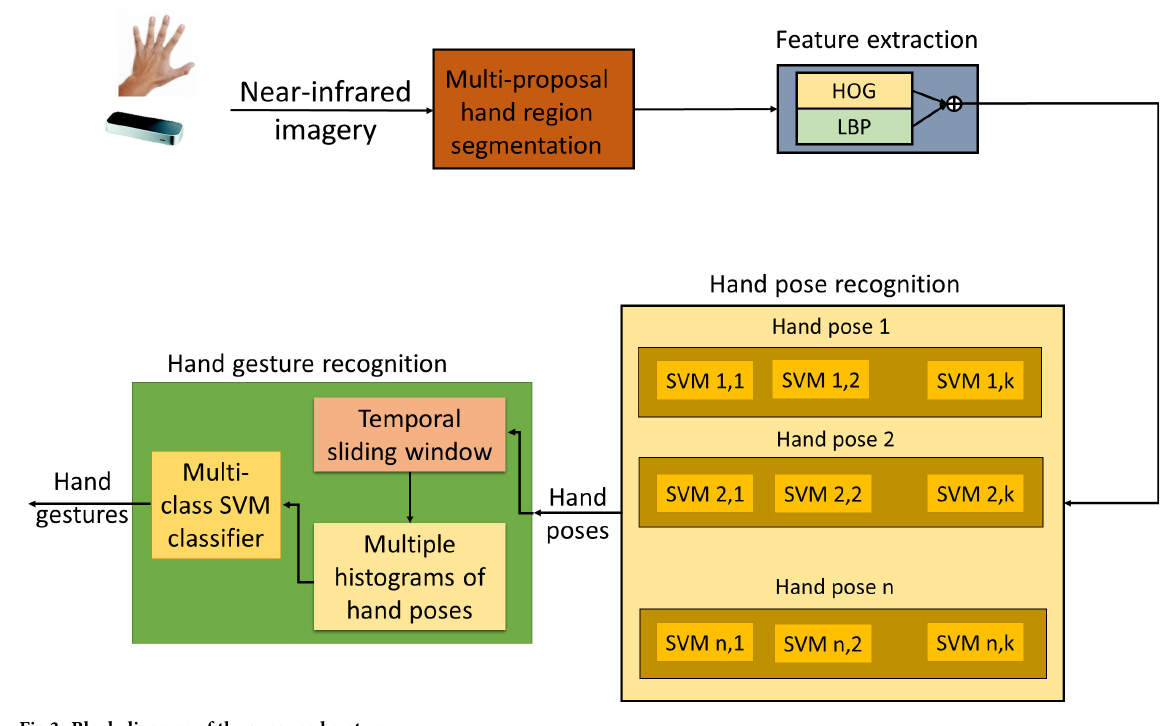
Fig 3. Block diagram of the proposed